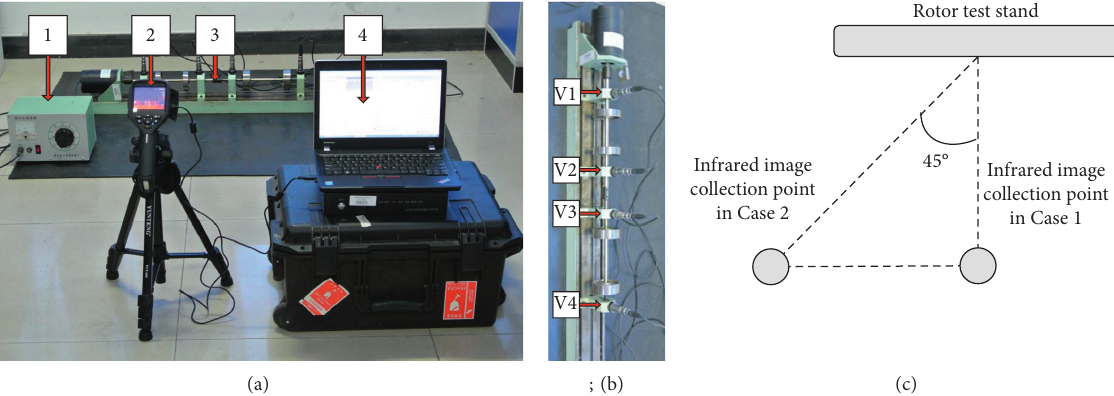
Figure 6: Illustration of the experimental setup: (a) acquisition systems of the experiment: (1) speed controller, (2) thermal camera, (3) rotor test stand, and (4) computer; (b) measuring points of vibration signals; (c) Positions of test stand and thermal camera in two cases.